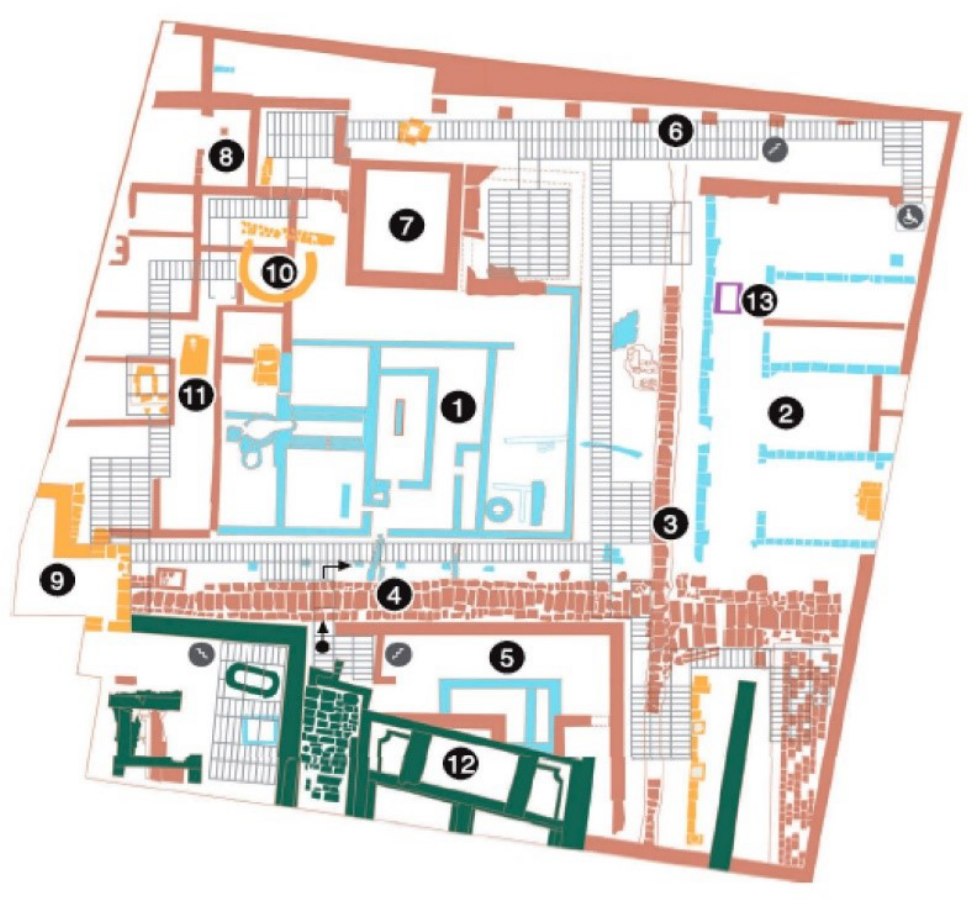
Figure 5. Museum